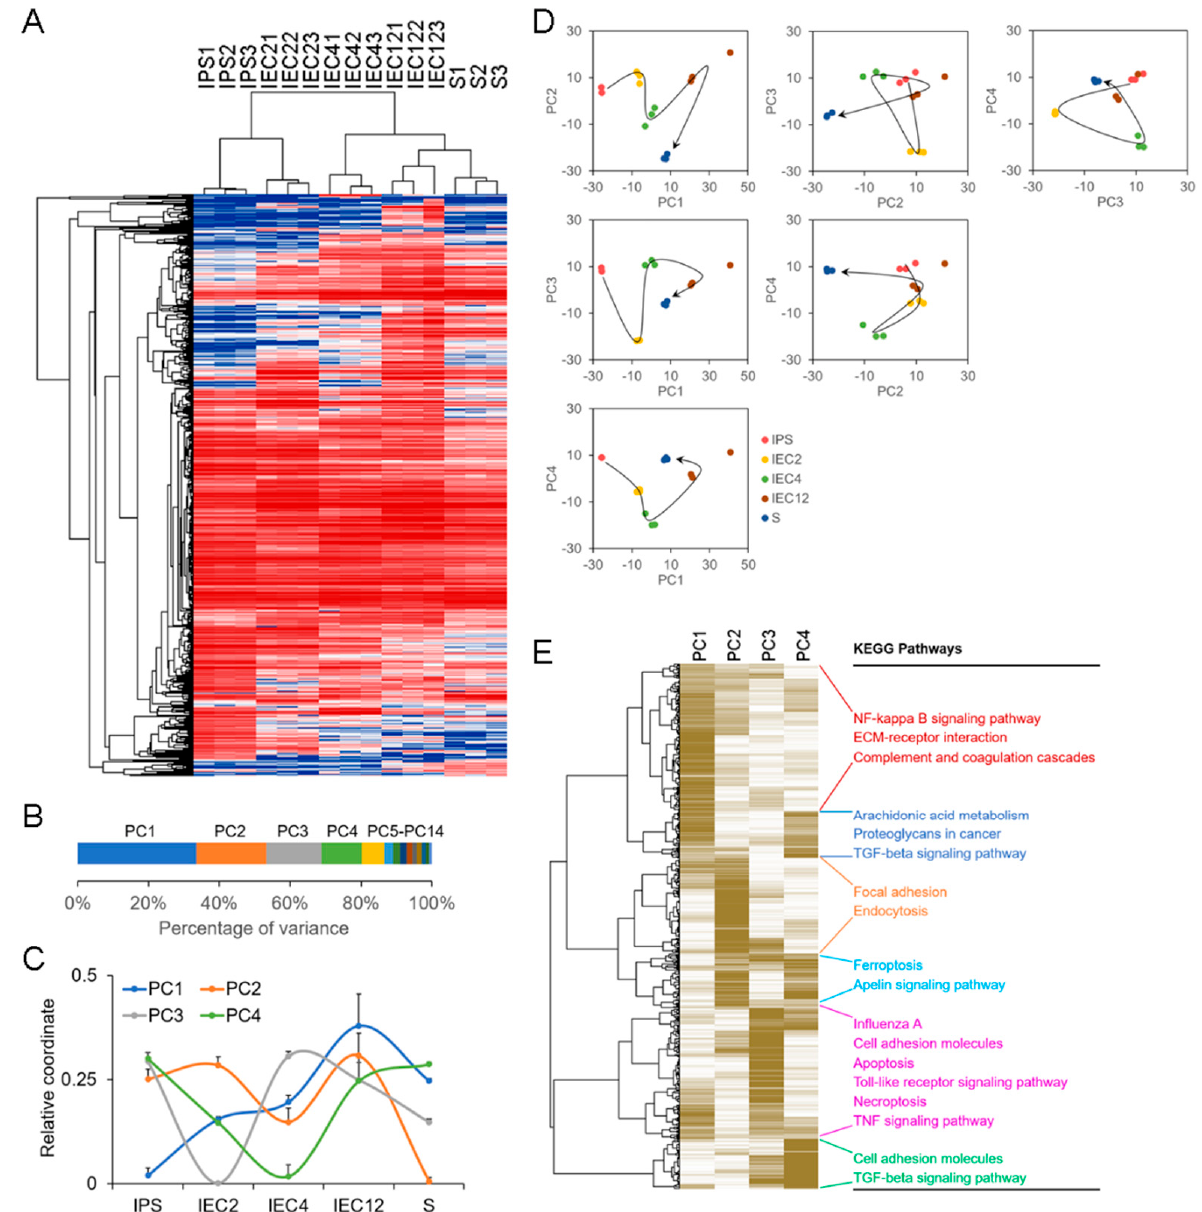
Figure 4. Genome − wide transcriptional profile analysis for the regulation of piPSC − EC differentia- tion. ( A ) Hierarchical clustering analysis of the genes differentially expressed between iPS cells and AOCs at p < 0.001, q < 0.001, |log2 fold change| > 3. Columns indicate samples and rows indicate genes. Blue indicates repression and red indicates promotion. ( B ) Principal component analysis (PCA) with the differentially expressed genes using R package ade4 (version 1.7-18). ( C ) The shift in each PC during the process of differentiation. A relative coordinate was calculated by normalizing the coordinates of all cells within each PC with a range from 0 to 1. The results are presented as the mean ± SD, n = 3. ( D ) Trajectory visualization in 2D using any two of the top four PCs. ( E ) Heatmap of the high contribution genes of the top four PCs. Columns indicate PCs and rows indicate genes. Brown indicates high contribution and white indicates low contribution. Pathway analysis of indicated genes was performed ( p < 0.05).